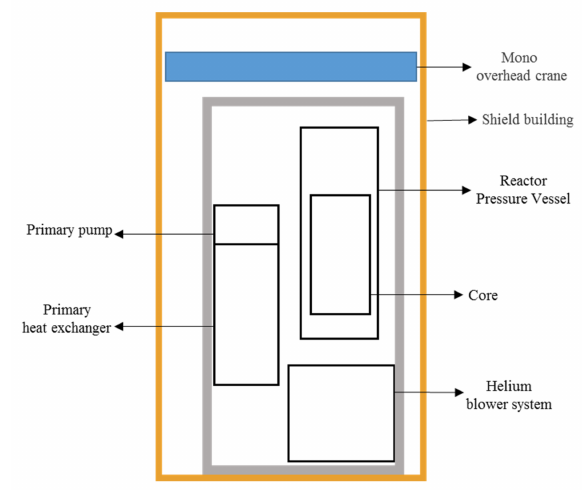
Figure A3. Cross-section of the HTR-PM reactor building [27].